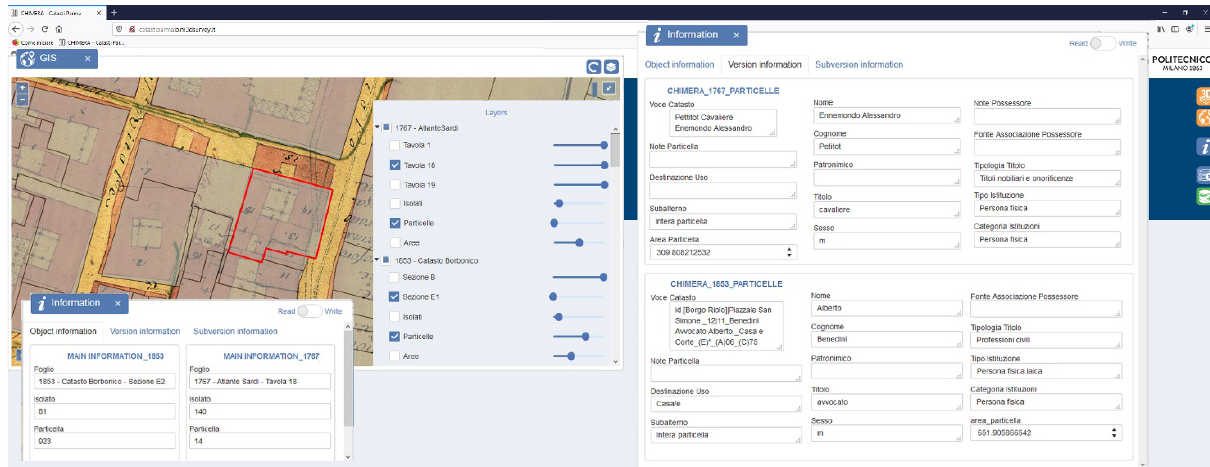
Figure 3. Example of multi-temporal query. The raster map refers to 1767 while the vector polygons represent parcels in 1853. The spatial overlap shows the transformations occurred, while the attribute sheet shows the information related to the selected parcel in the two historical periods.